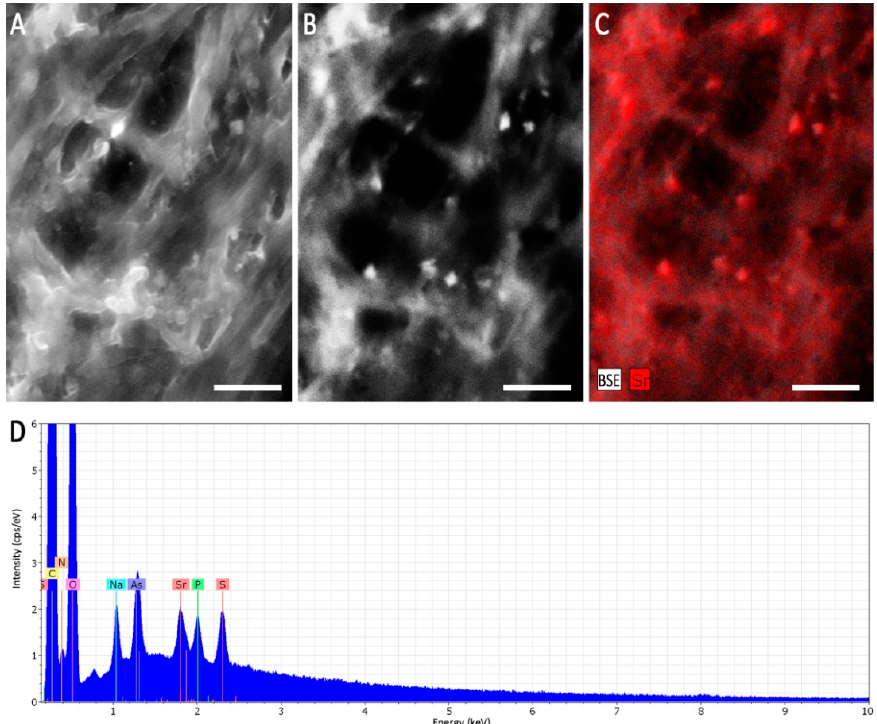
Figure 4. Scanning electron microscopy of Aspergillus sp. SFB31 grown with SrCl 2 . Surface of a mycelium using the SE signal ( A ), mineral agglomerations depicted as bright spots using the BSE signal ( B ), and the respective EDX mapping of the Sr-channel ( C ) showing a correlation of the spots are given. The EDX sum spectrum of the imaged area shows a clear Sr-peak ( D ). Scale bars are 5 µm.